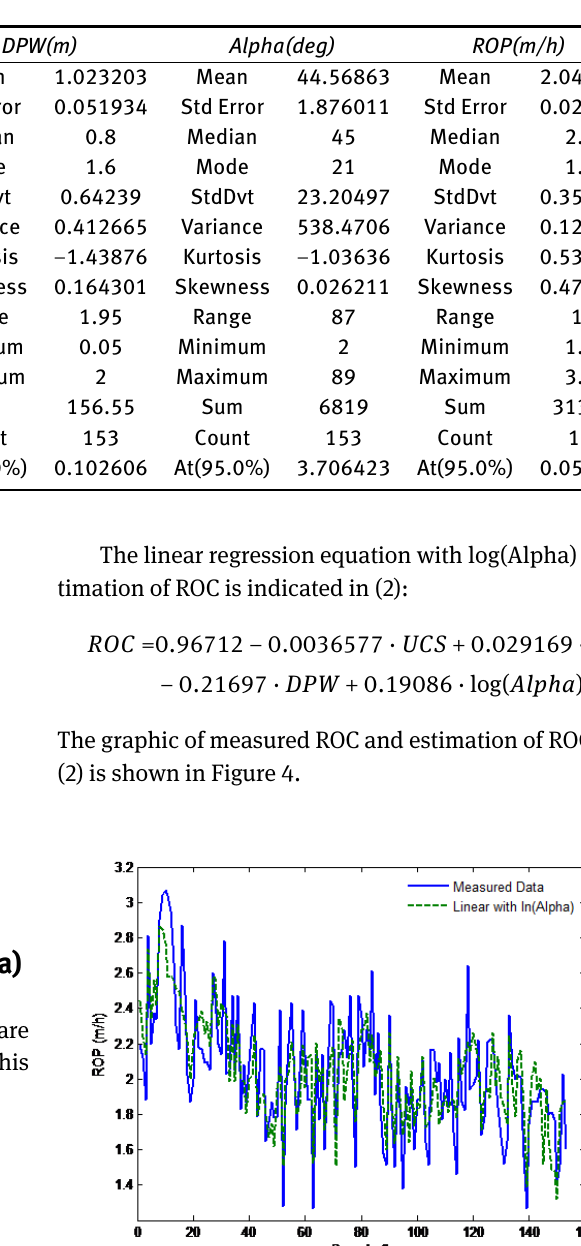
Table 2: Statistical summary of variables.